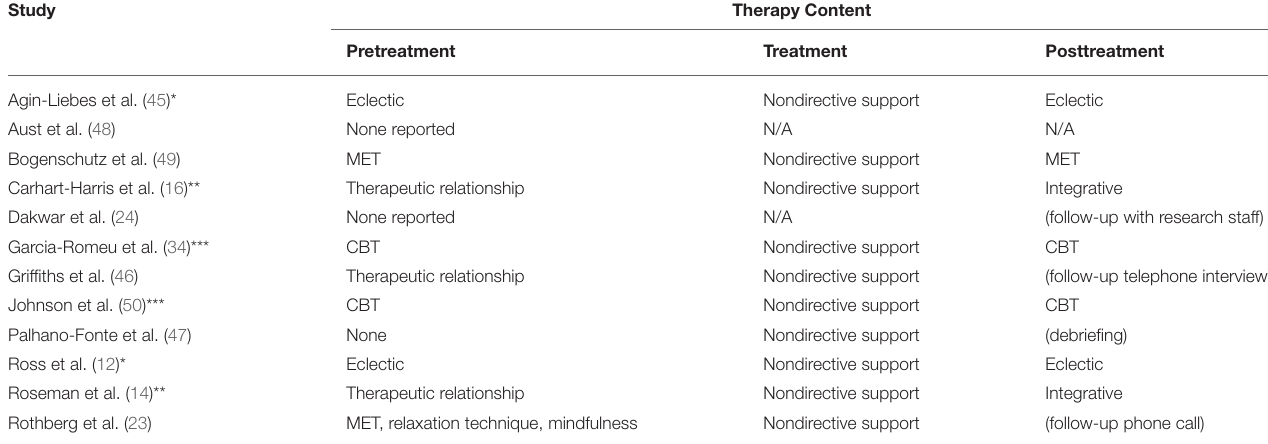
TABLE 2 | Accompanying model of